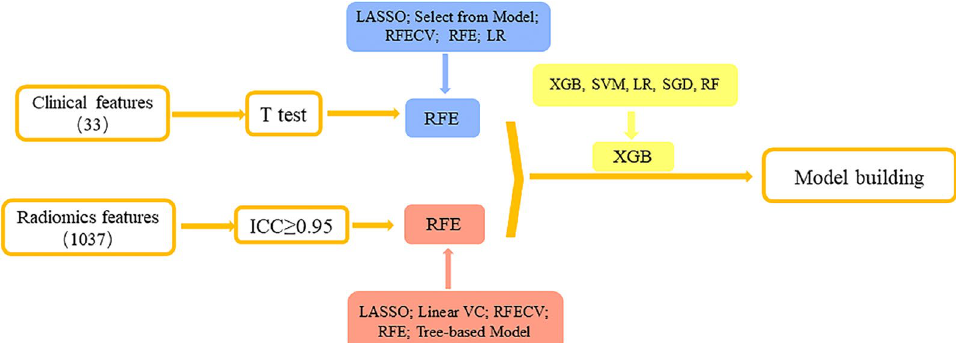
Fig. 2 Flowchart of the most important features’ selection (The numbers in parentheses are characteristic numbers; ICC, Intercorrelation Coefficient; LASSO, Least Absolute Shrinkage and Selection Operator; RFECV, Recursive Feature Elimination Cross Validation; RFE, Recursive Feature Elimination; LR, Logistic Regression; Linear SVC, Linear Support Vector Classification; SGD, Stochastic Gradient Descent; SVM, Support Vector Machine; RF, Random Forest; XGB, eXtreme Gradient